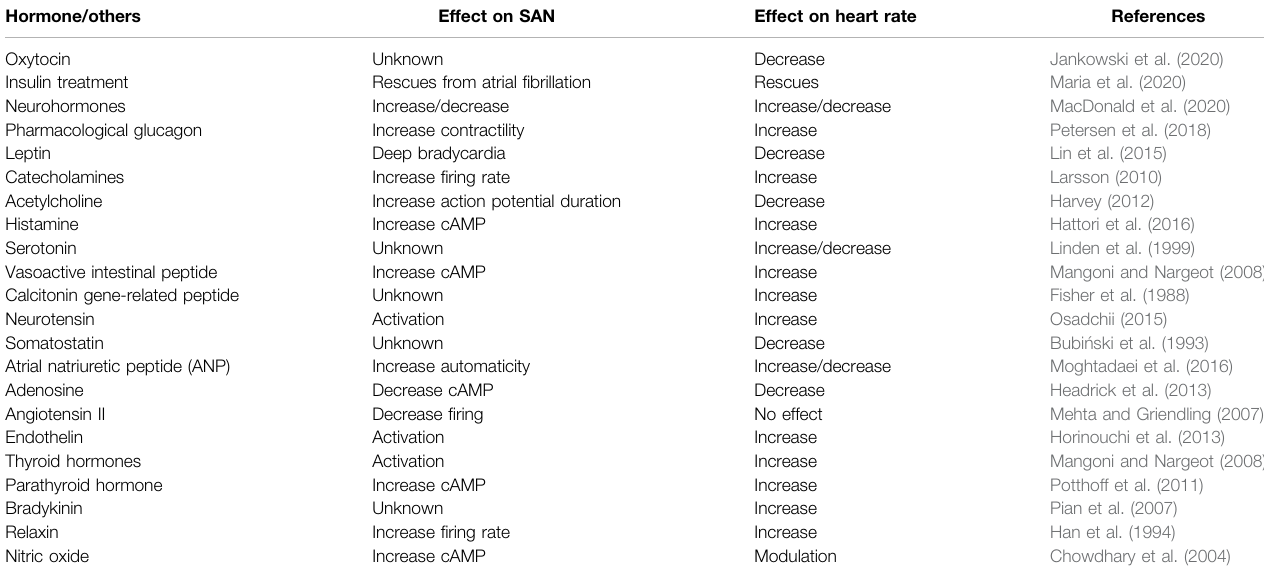
TABLE 1 | Neurohormonal and endocrine control of sinoatrial node activity and heart rate. Hormone/others